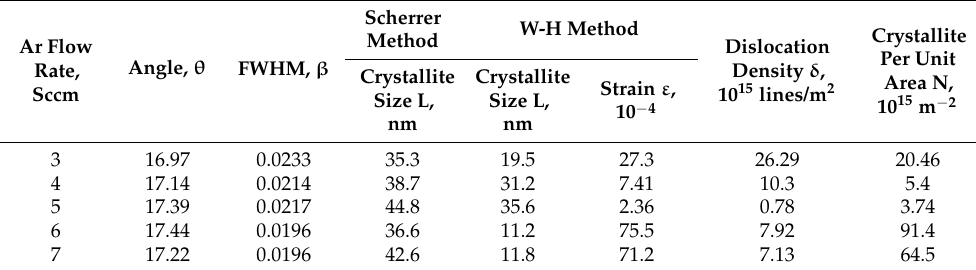
Table A1. Geometric parameters obtained from as-grown WS 2 thin film XRD